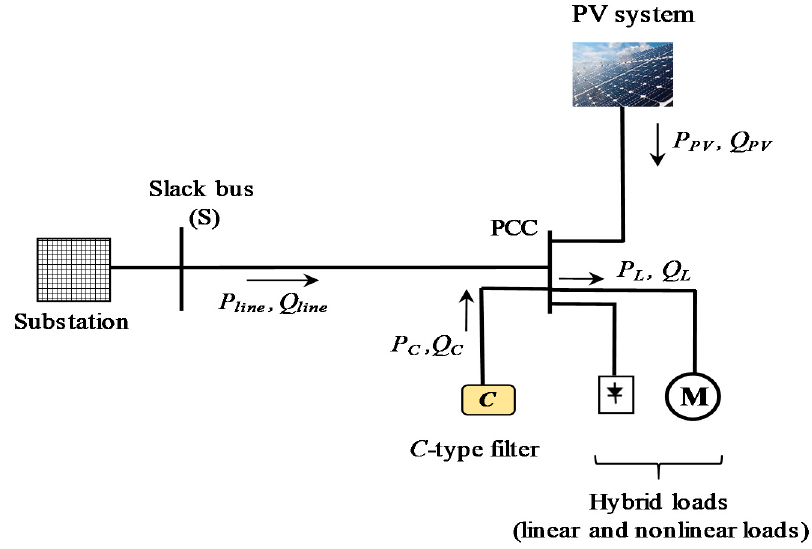
Figure 1. The test system under study.